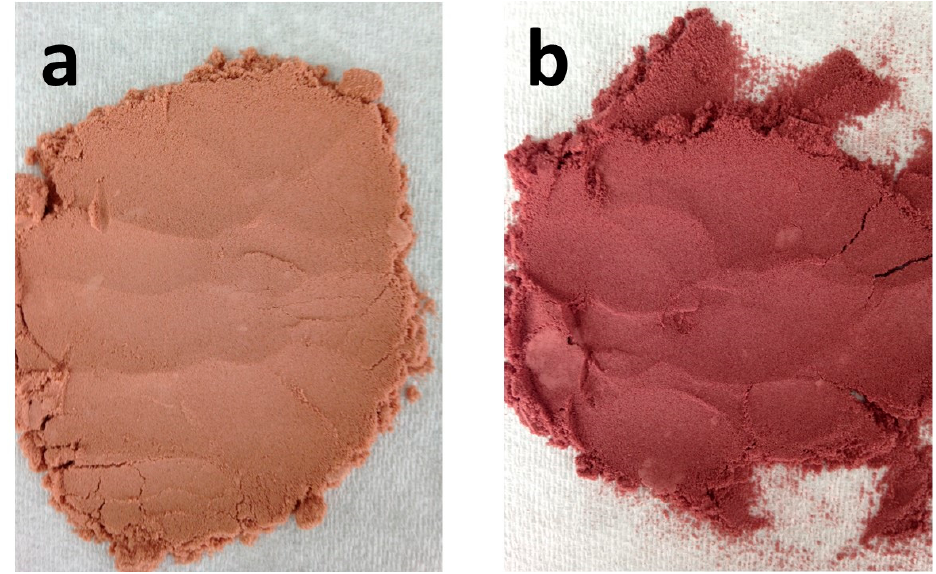
Figure 1. Maltodextrin encapsulated spray-dried Listan Prieto ( a ) and Syrah ( b ) wine samples.